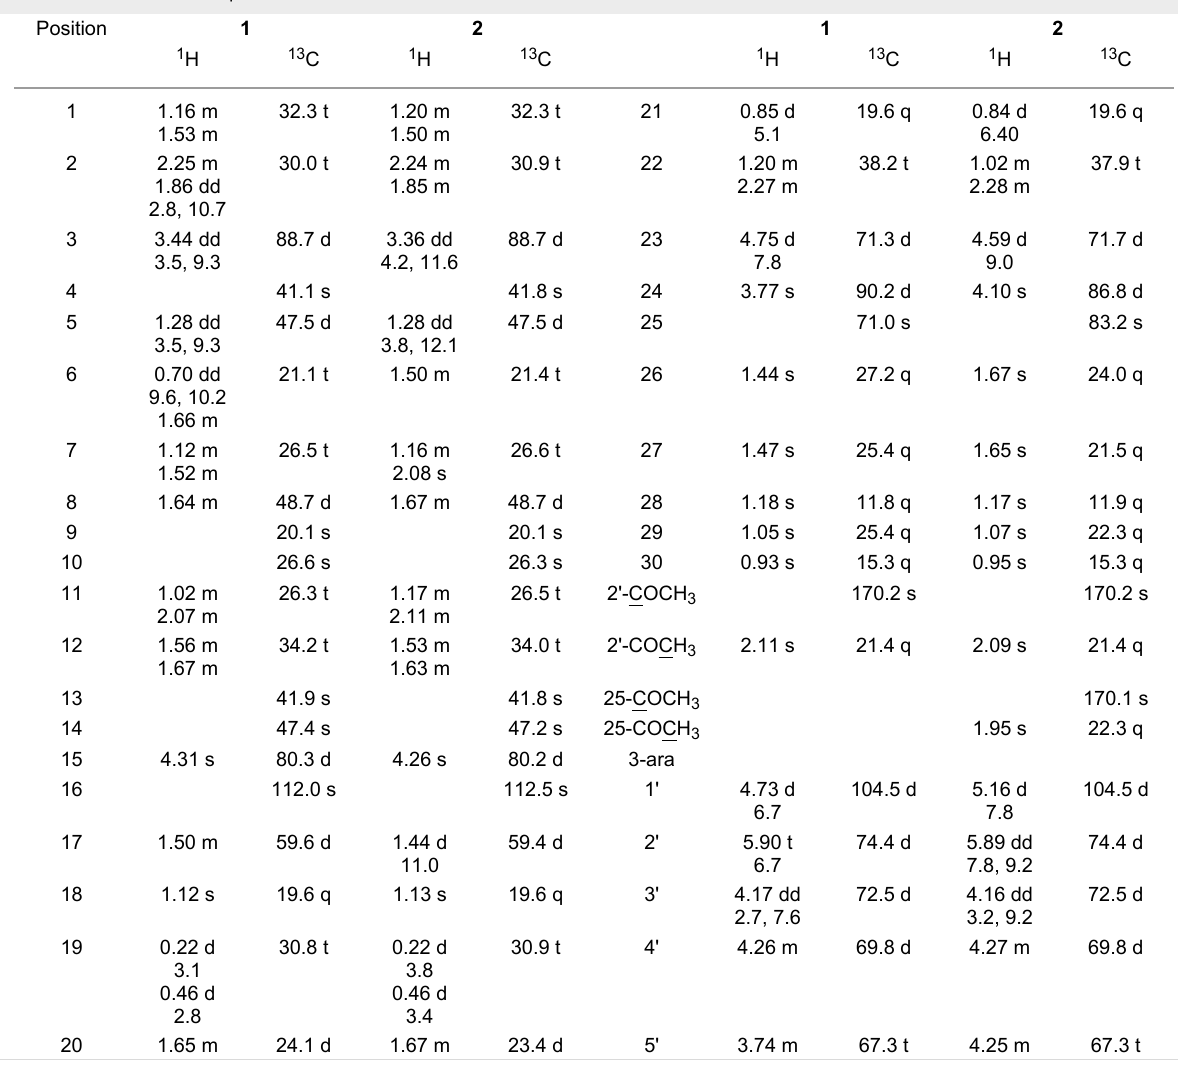
Table 1: NMR Data for compounds 1 and 2